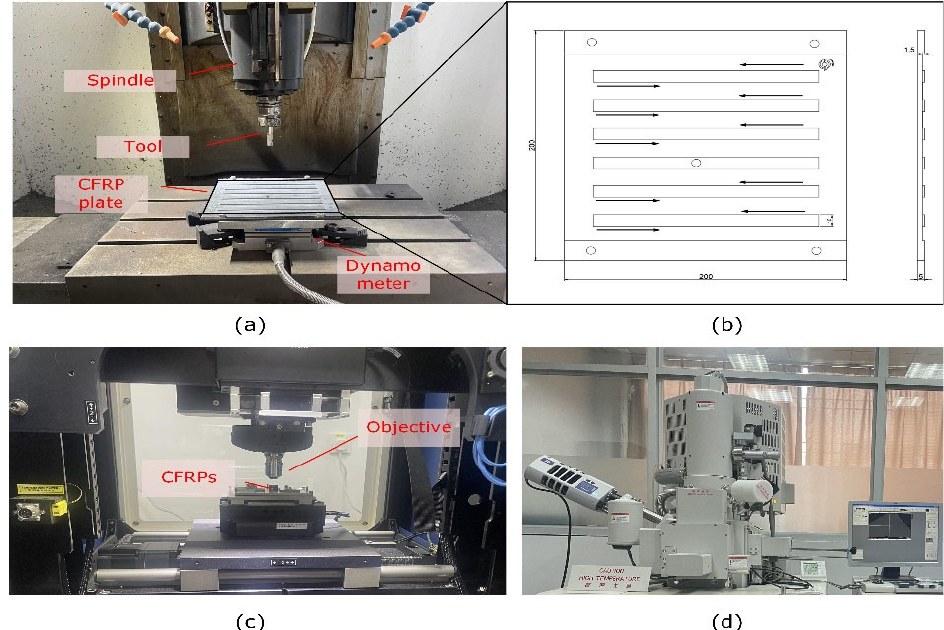
Figure 1. ( a ) experimental platform, ( b ) milling method, ( c ) evaluation of surface topography, and ( d ) the observation of tool wear width and subsurface. Table 2. The tool geometry and the machining parameters. The Radius of The Feed Rake Angle (o) Flank Angle (o) Cutter (mm) (mm/min) 0 11 0.1 60 The speed of spindle (rad/min) The depth of cut (mm) The width of cut (mm) 5000 0.8